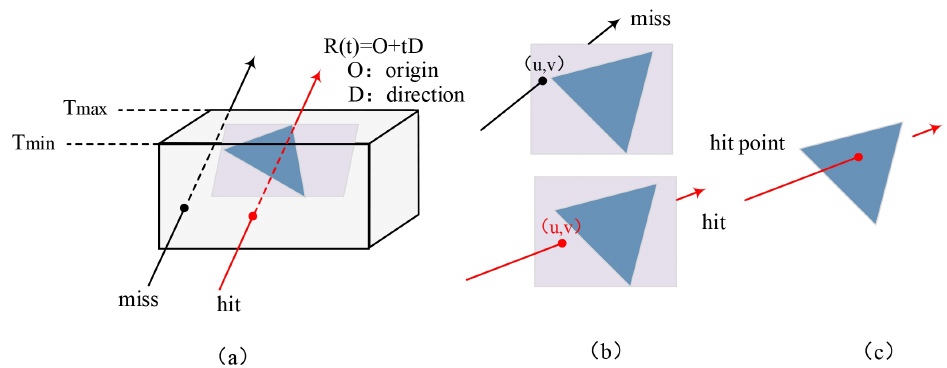
Figure 3. Triangle intersection test. ( a ) Ray-plane test, ( b ) barycentric test and ( c ) final hit point calculation.